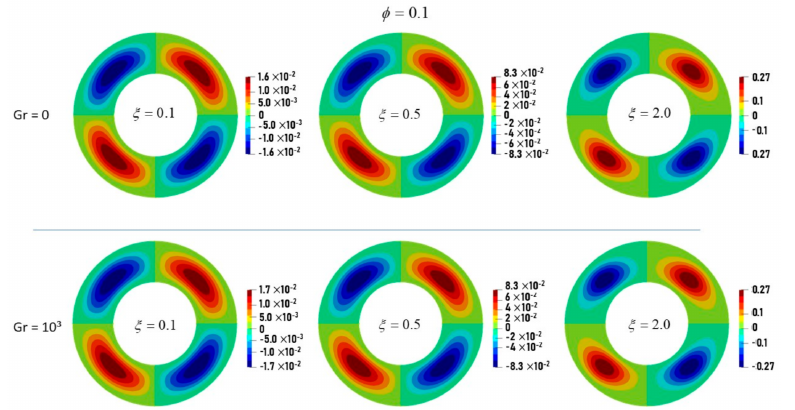
Figure 3. Contour plots of the streamlines ψ of transverse velocities (cid:101) v r , (cid:101) v θ for various values of ξ and Gr for φ = 0.1.